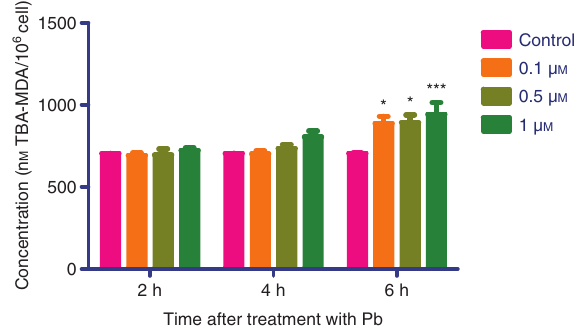
Figure 2: The effect of Pb acetate on formation of reactive oxygen species (ROS) in lymphocytes.